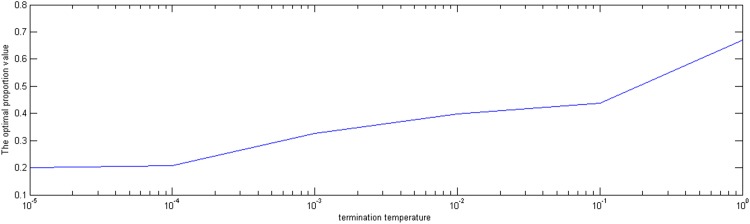
The effect of termination temperature on the optimal proportion value.